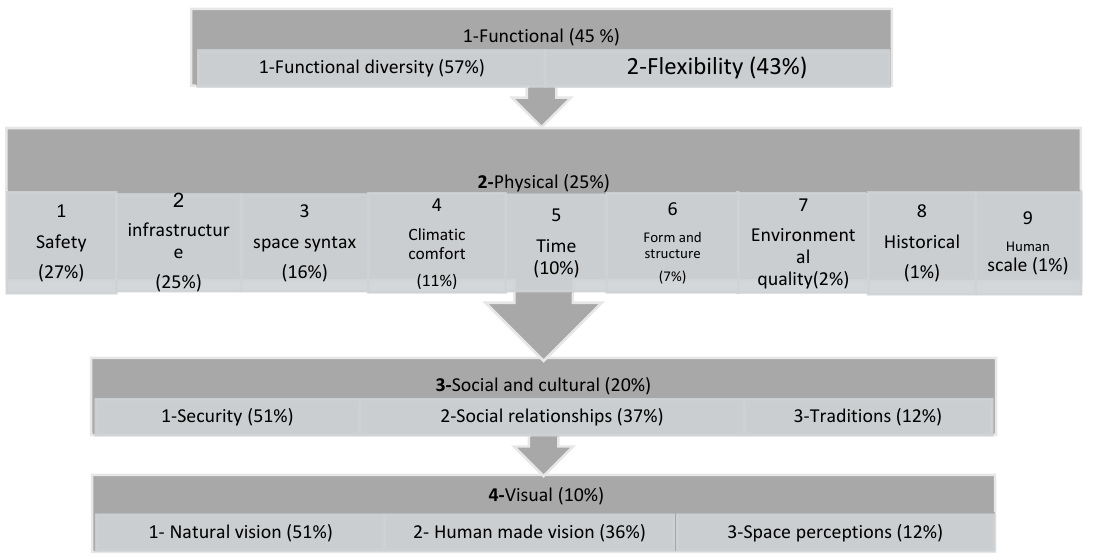
Figure 9. Prioritizing the criteria and the sub-criteria affecting physical activities.